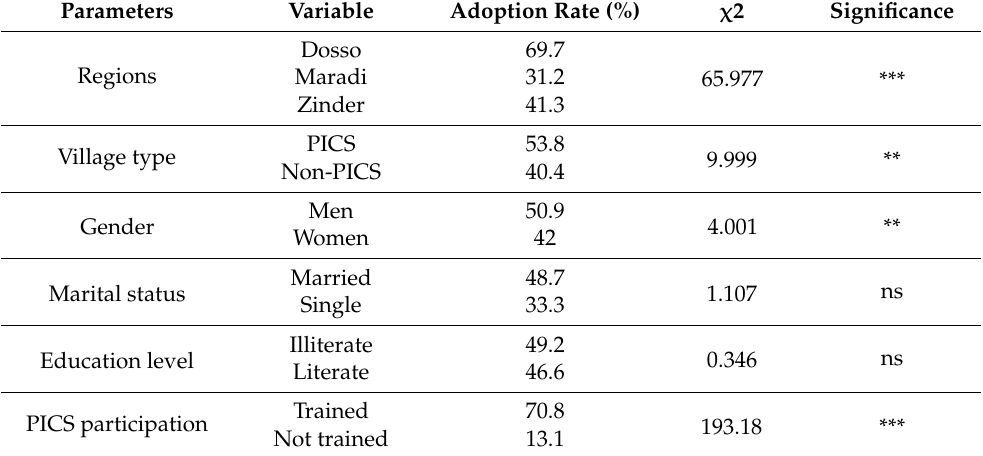
Table 3. Adoption of the PICS technology by farmers (%) in Dosso, Maradi, and Zinder regions of